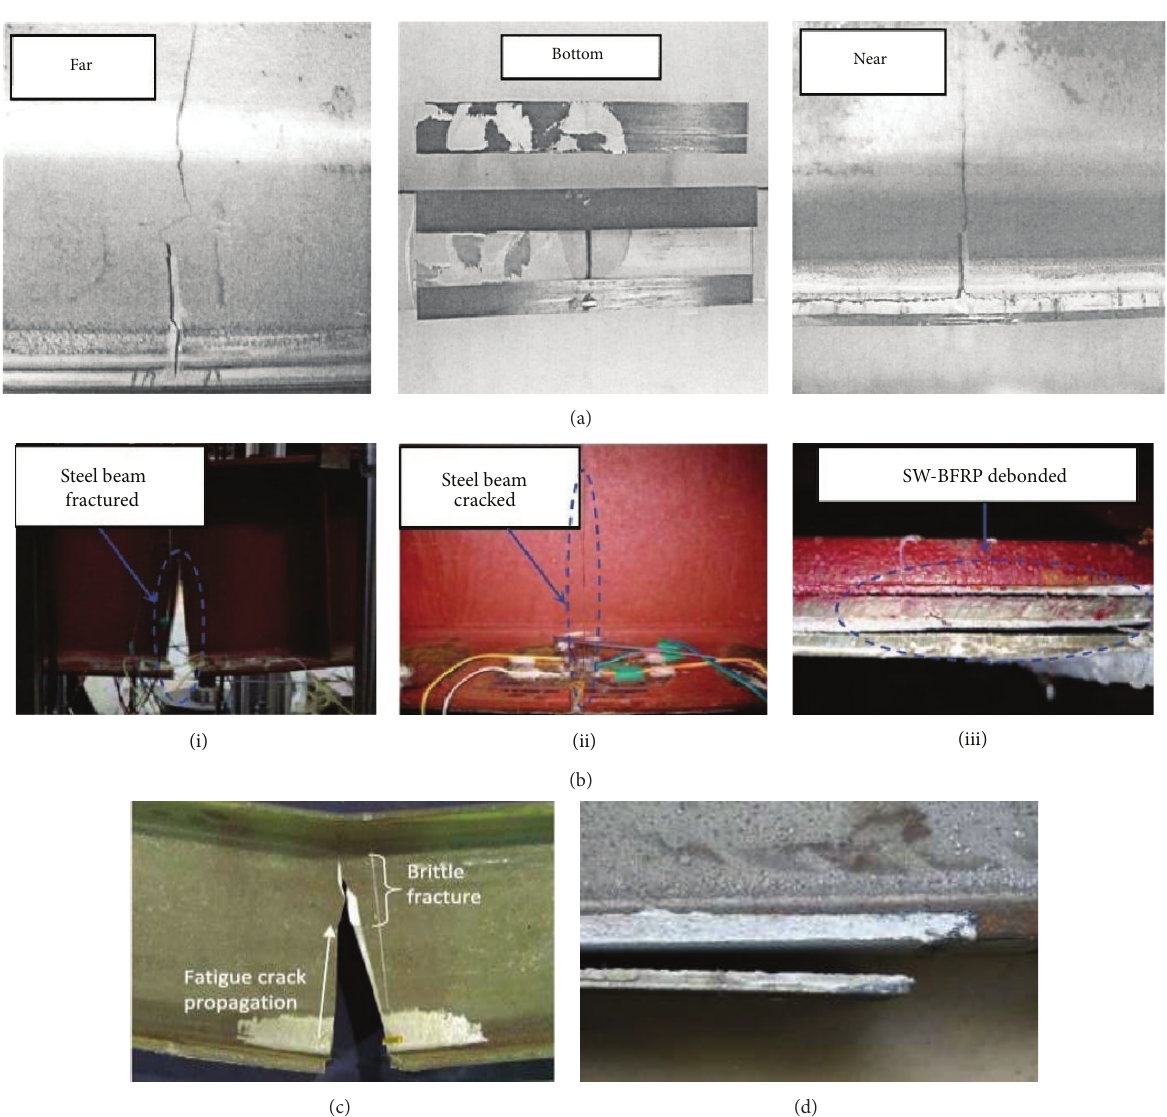
Figure 11: Failure modes of retrofitted beams using FRP plates (a) [14], (b) [38], (c) crack propagation and brittle web fracture [37], and (d) end debonding